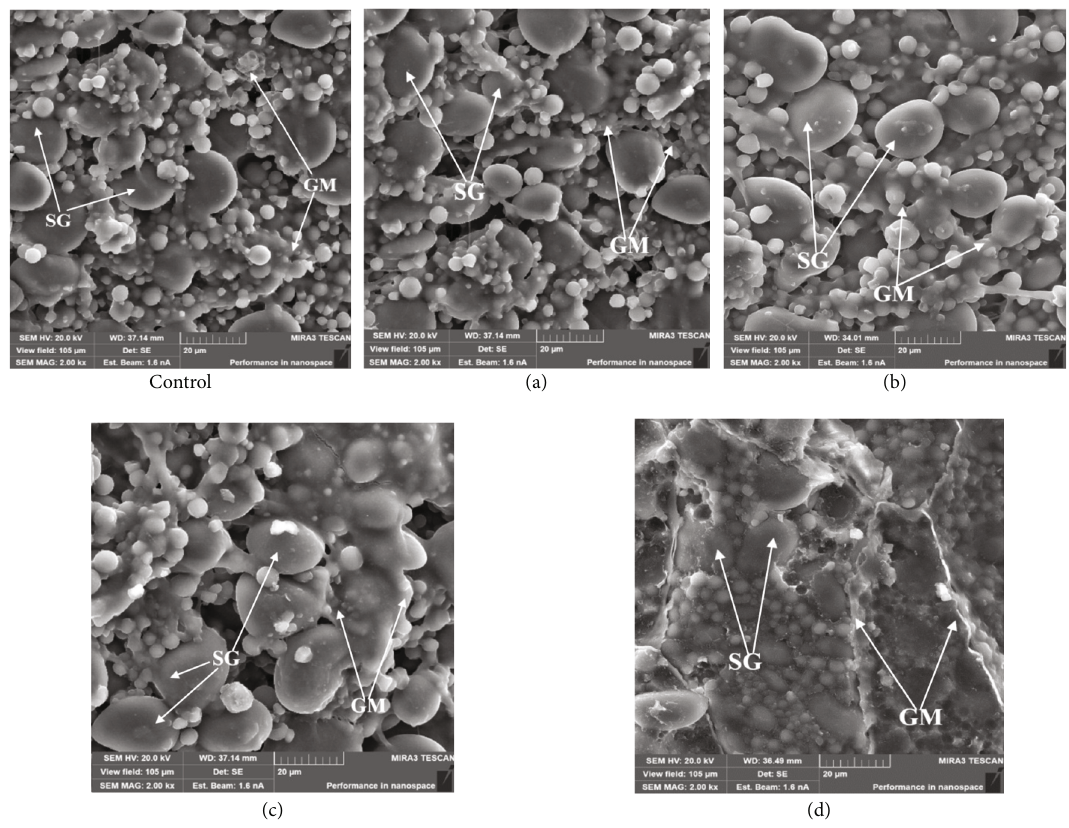
Figure 3: Characteristic view of electronic microphotographs of the cross section of the control (a) and experimental (b) wheat grain samples (Sample 1) after 8 hours of soaking, TESCAN MIRA3 SEM, magni fi cation 2000x: SG: starch grains; GM: gluten